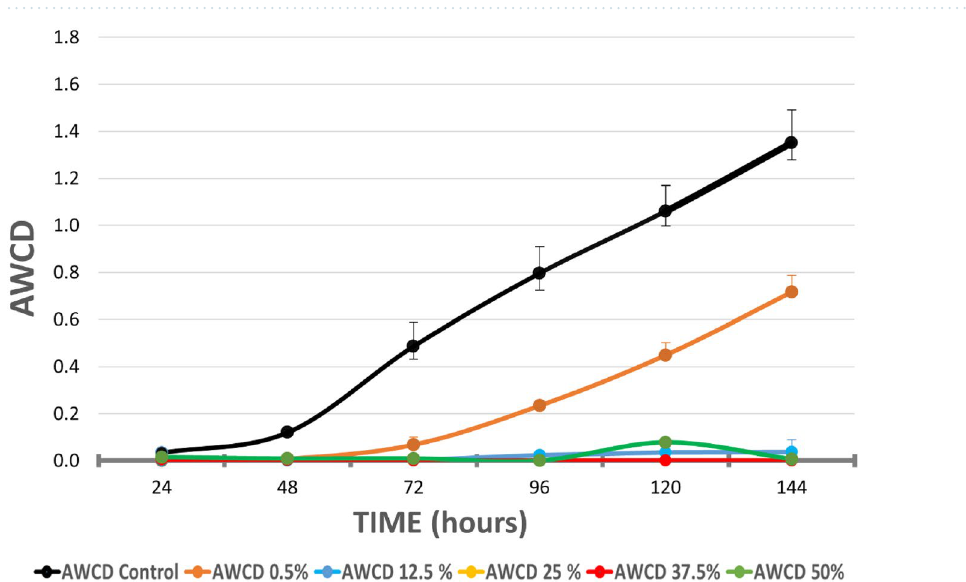
Figure 4. AWCD vs time curves of metabolized substrates in Biolog EcoPlates based on 144-h incubation of soil microorganisms exposed to Satureja montana hydrolate. Black line is the negative control (soil microorganisms that have not been treated with hydrolate). Each point is the average value of three replicates. Error bars represent the standard deviation of mean of three replicates (n =